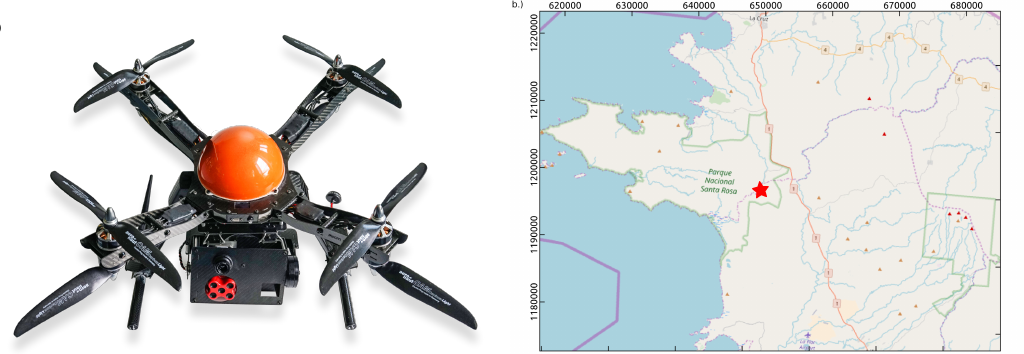
Figure 1. ( a ) Rotorkonzept RKM-8X octocopter with Micasense RedEdge (red camera) and FLIR TAU2 640 (lens over the Micasense) placed in a two-axis stabilizing gimbal. ( b ) Location of the flux site within the Santa Rosa National Park Environmental Monitoring Super-Site (SRNP-EMSS), Costa Rica (map: Open Street Map).